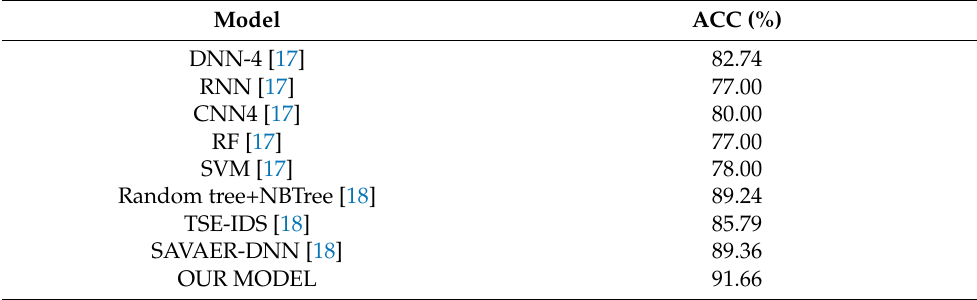
Table 5. The performance